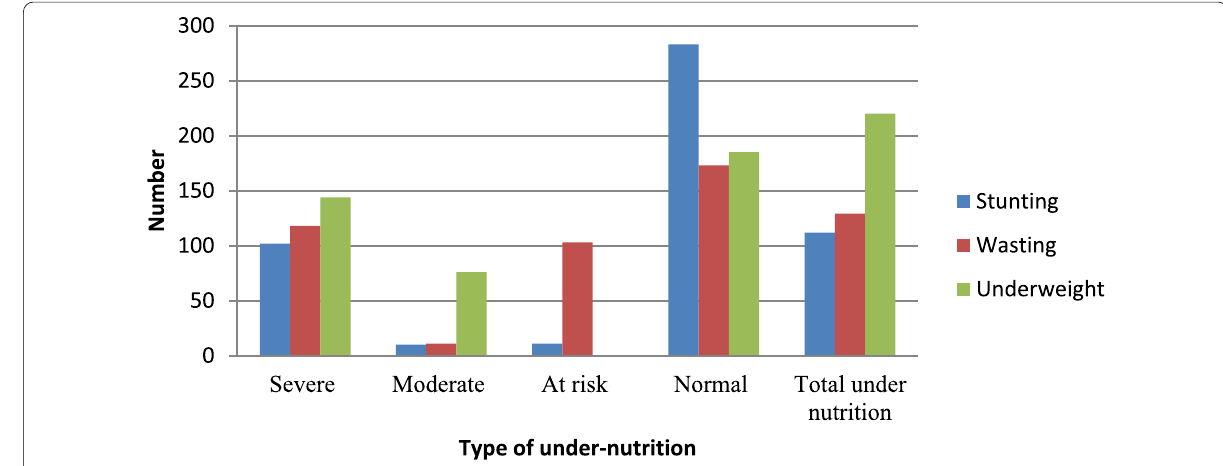
Fig. 3 Type and severity of under-nutrition among study participants, Gedeb District, Gedeo Zone, southern Ethiopia,